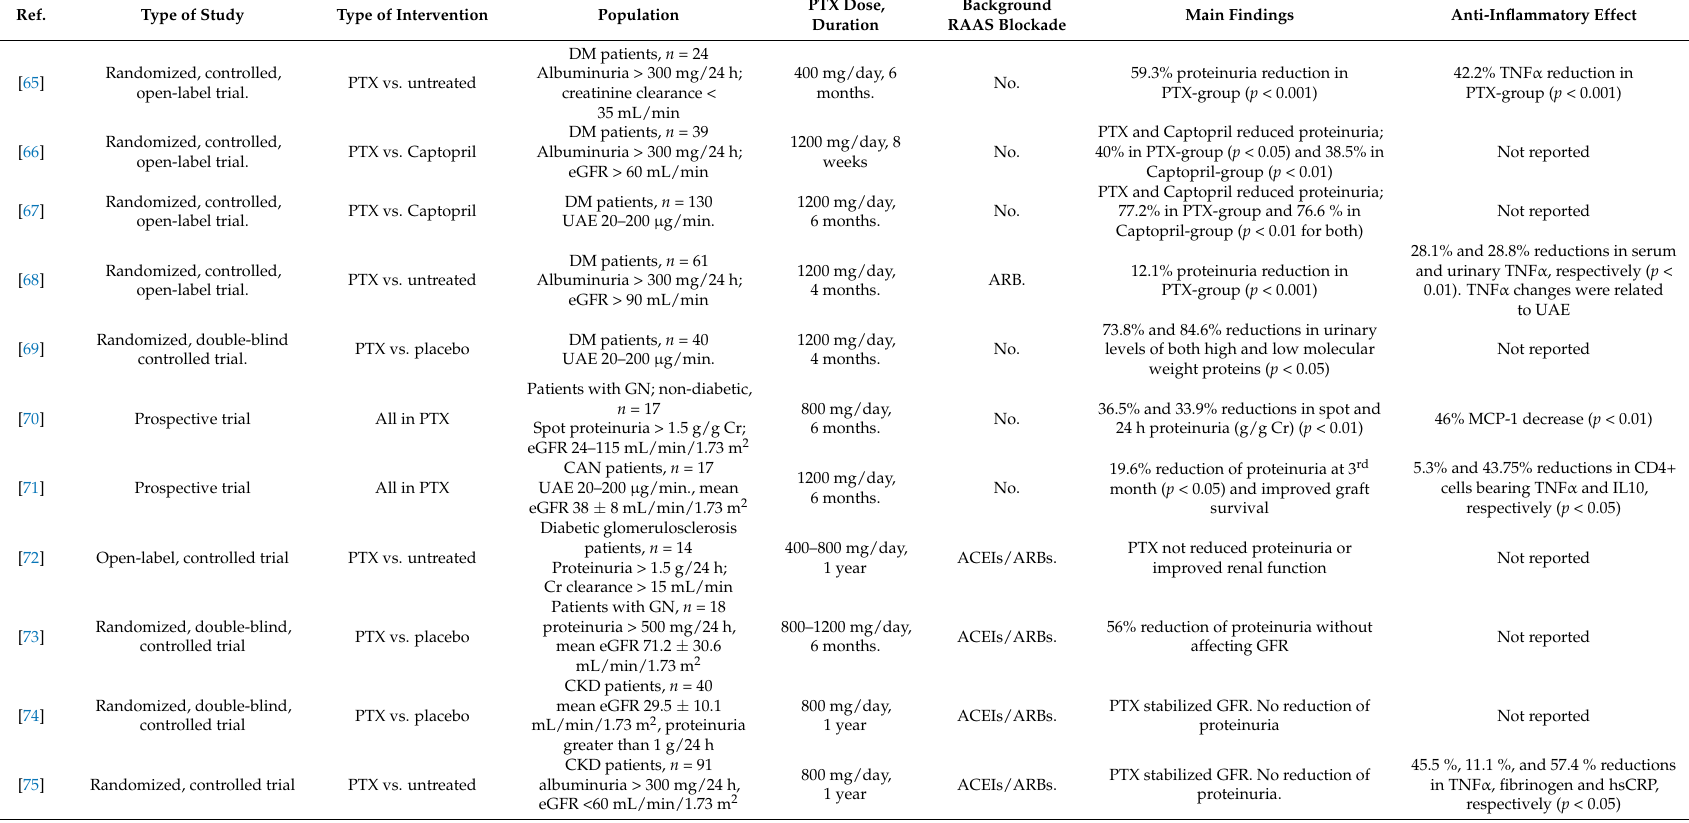
Table 2. Main clinical studies on the use of PTX in diabetic